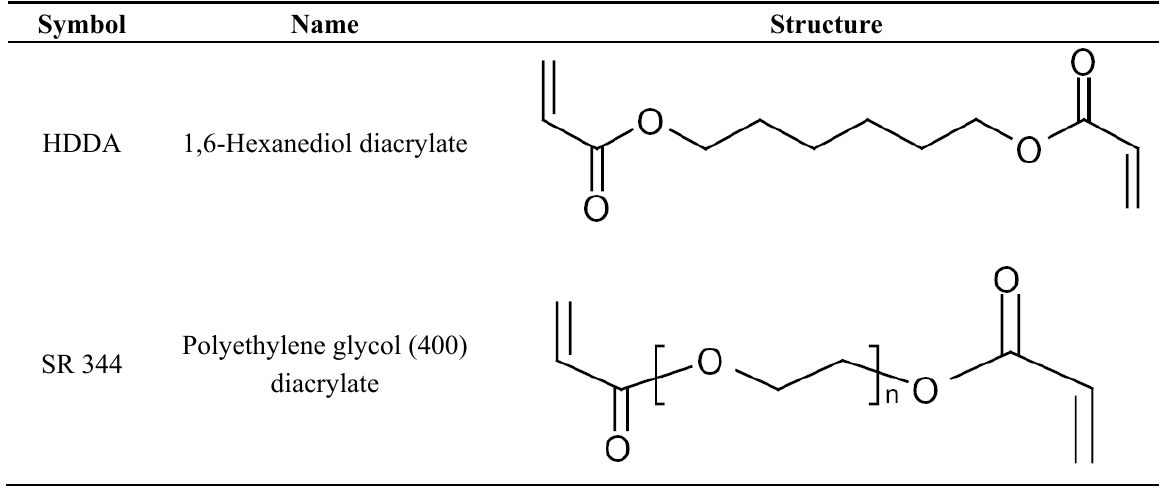
Table 3. Chemical structures of the UV-curable acrylic